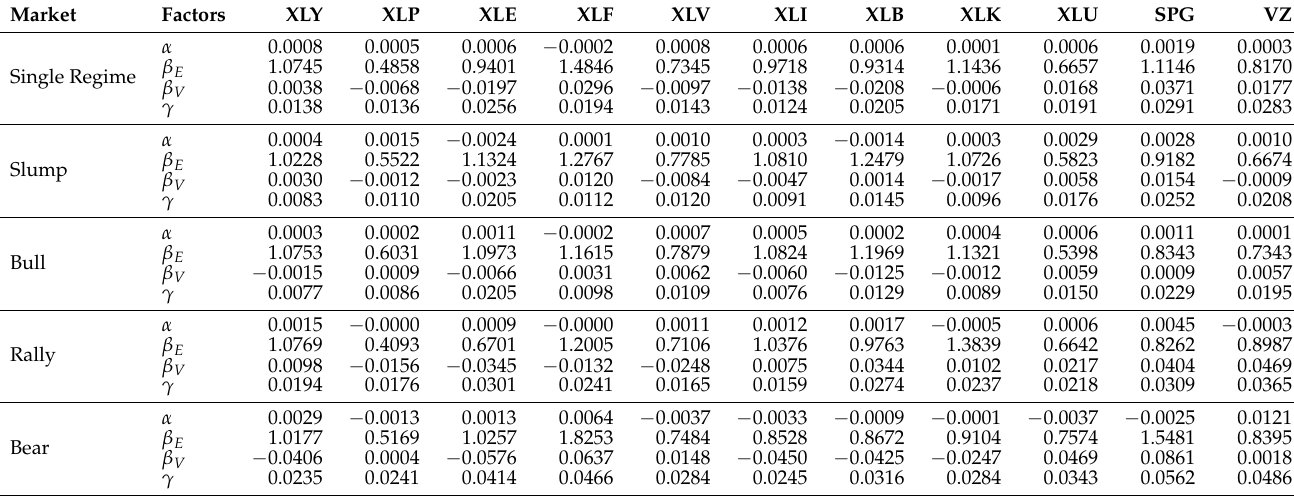
Table 4. Regime-dependent weekly asset return